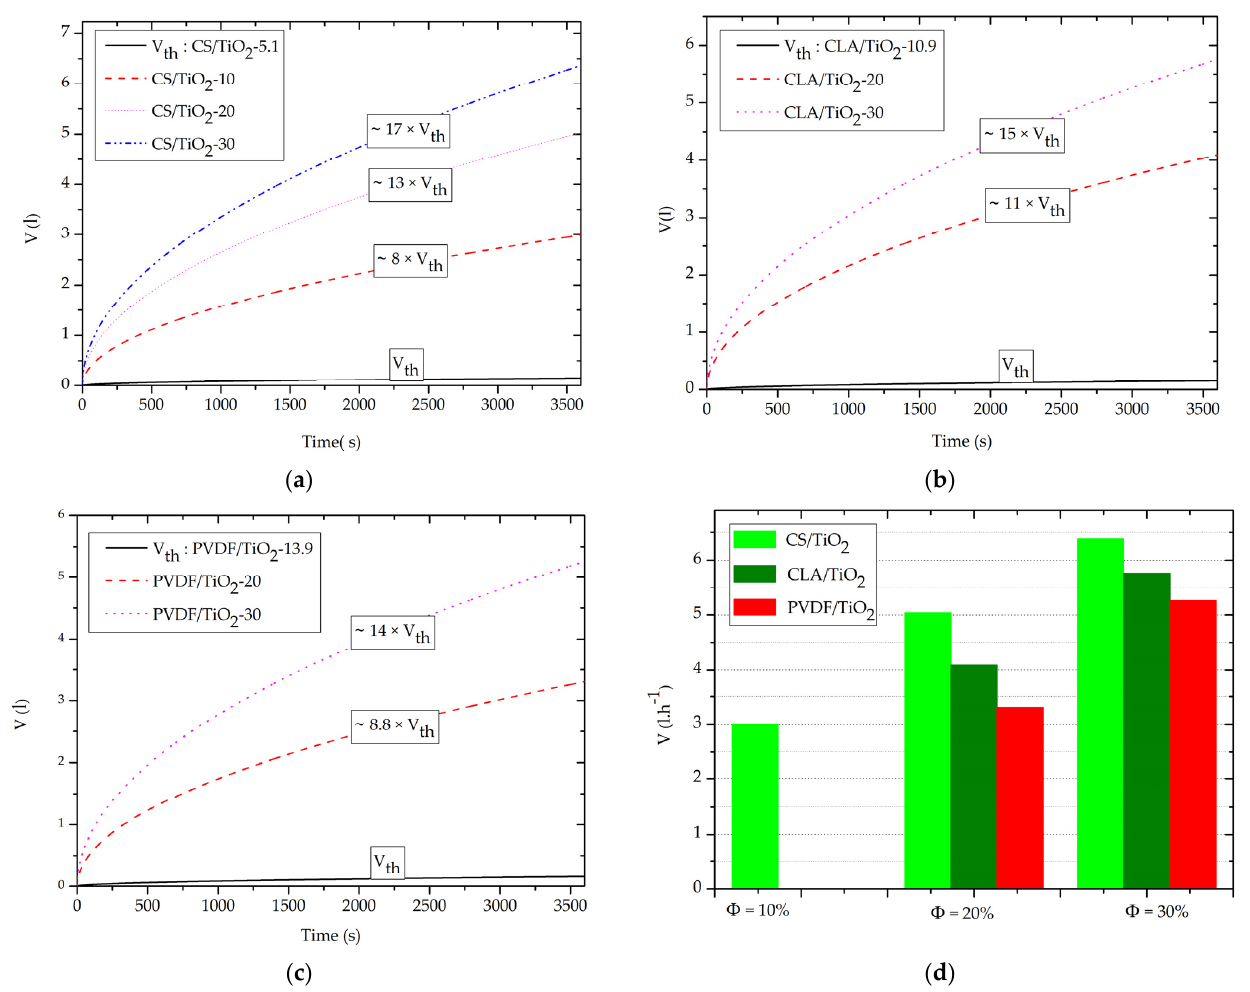
Figure 8. Evolution of the capillary-driven water volume V(t) for with S = 1 m 2 and r pe = 5 nm. ( a ) CS/TiO 2 , ( b ) CLA/TiO 2 , PVDF/TiO 2 , ( d ) capillary-driven water flow rate (L·h − 1 ) as function of the Ф ( a ) CS/TiO 2 , ( b ) CLA/TiO 2 , ( c ) PVDF/TiO 2 , ( d ) capillary-driven water flow rate (L · h − 1 ) as function of TiO 2 NPs. of the φ of TiO 2